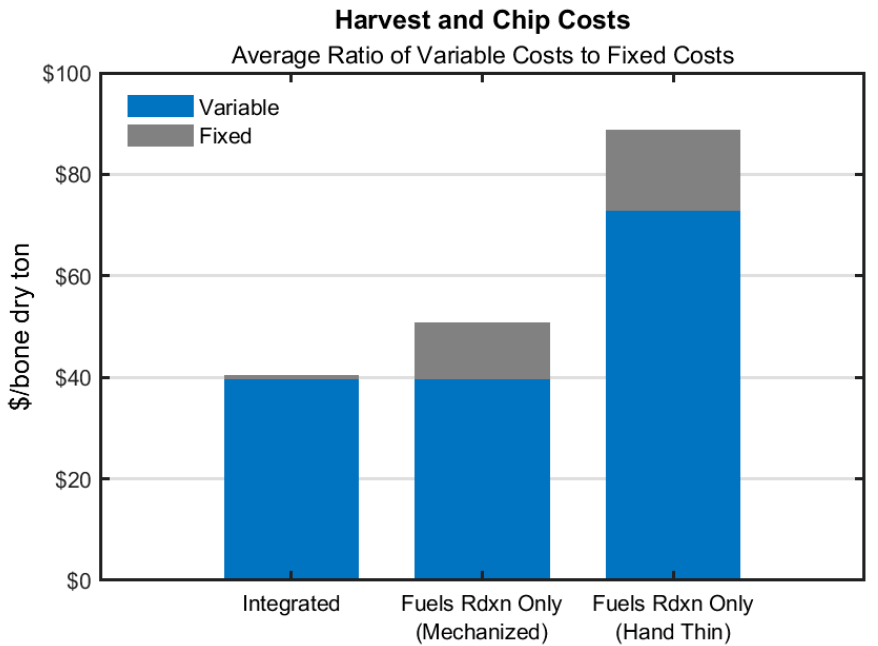
Figure 4. Comparison of treatment costs to harvest and chip biomass across scenarios for each harvest unit—haul costs are not included.